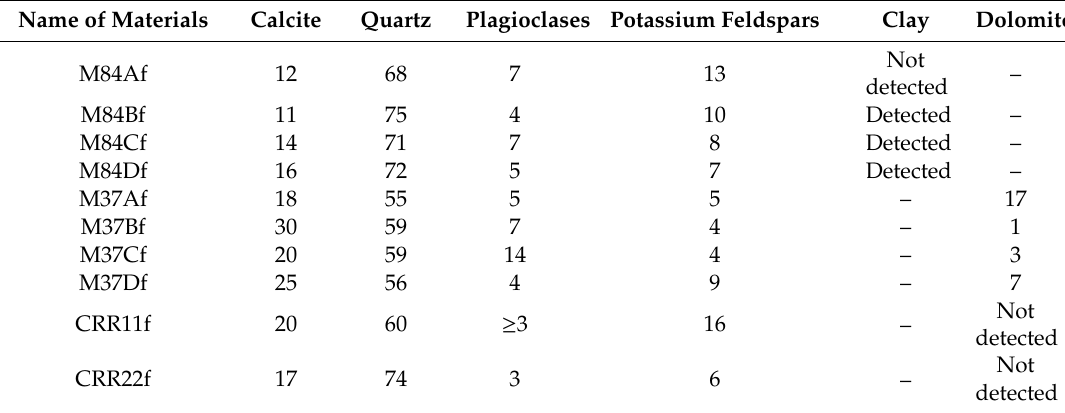
Figure 5. Capacity of water capture from atmospheric air of samples (M84Af to Df). Table 5. Mineral composition of the di ff erent samples determined by XRD